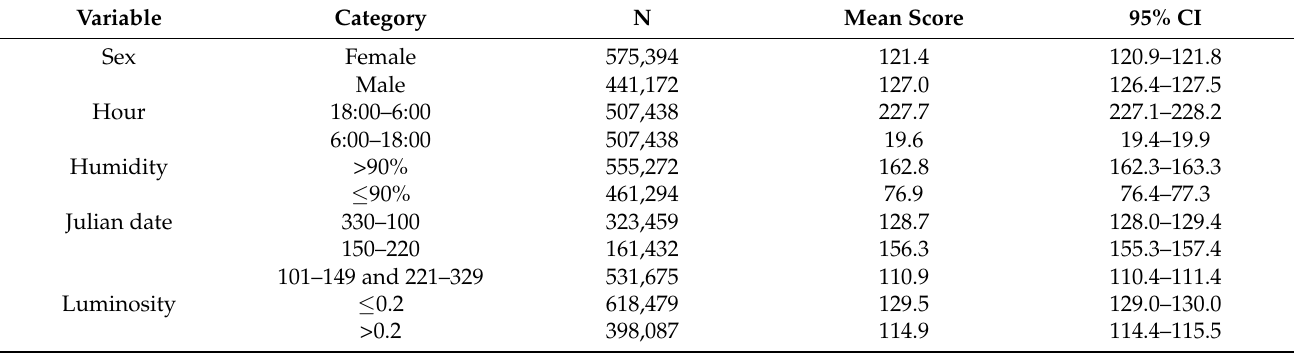
Table A1. Activity scores (means and 95% CI) based on accelerometers deployed on 12 Javan slow lorises (six females and six males) between June 2014 and October 2019. The categories considered are based on the output of Generalized Additive Mixed Models (Table 1; Figure